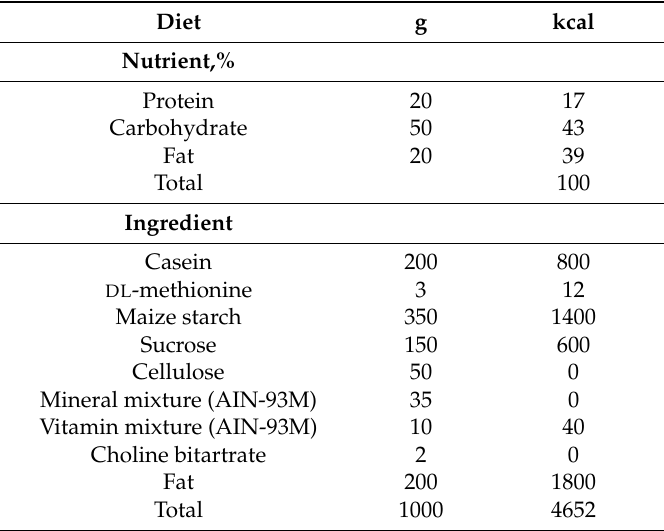
Table 1. Nutrient content and ingredient composition of the experimental diets. Diet g kcal Nutrient,%